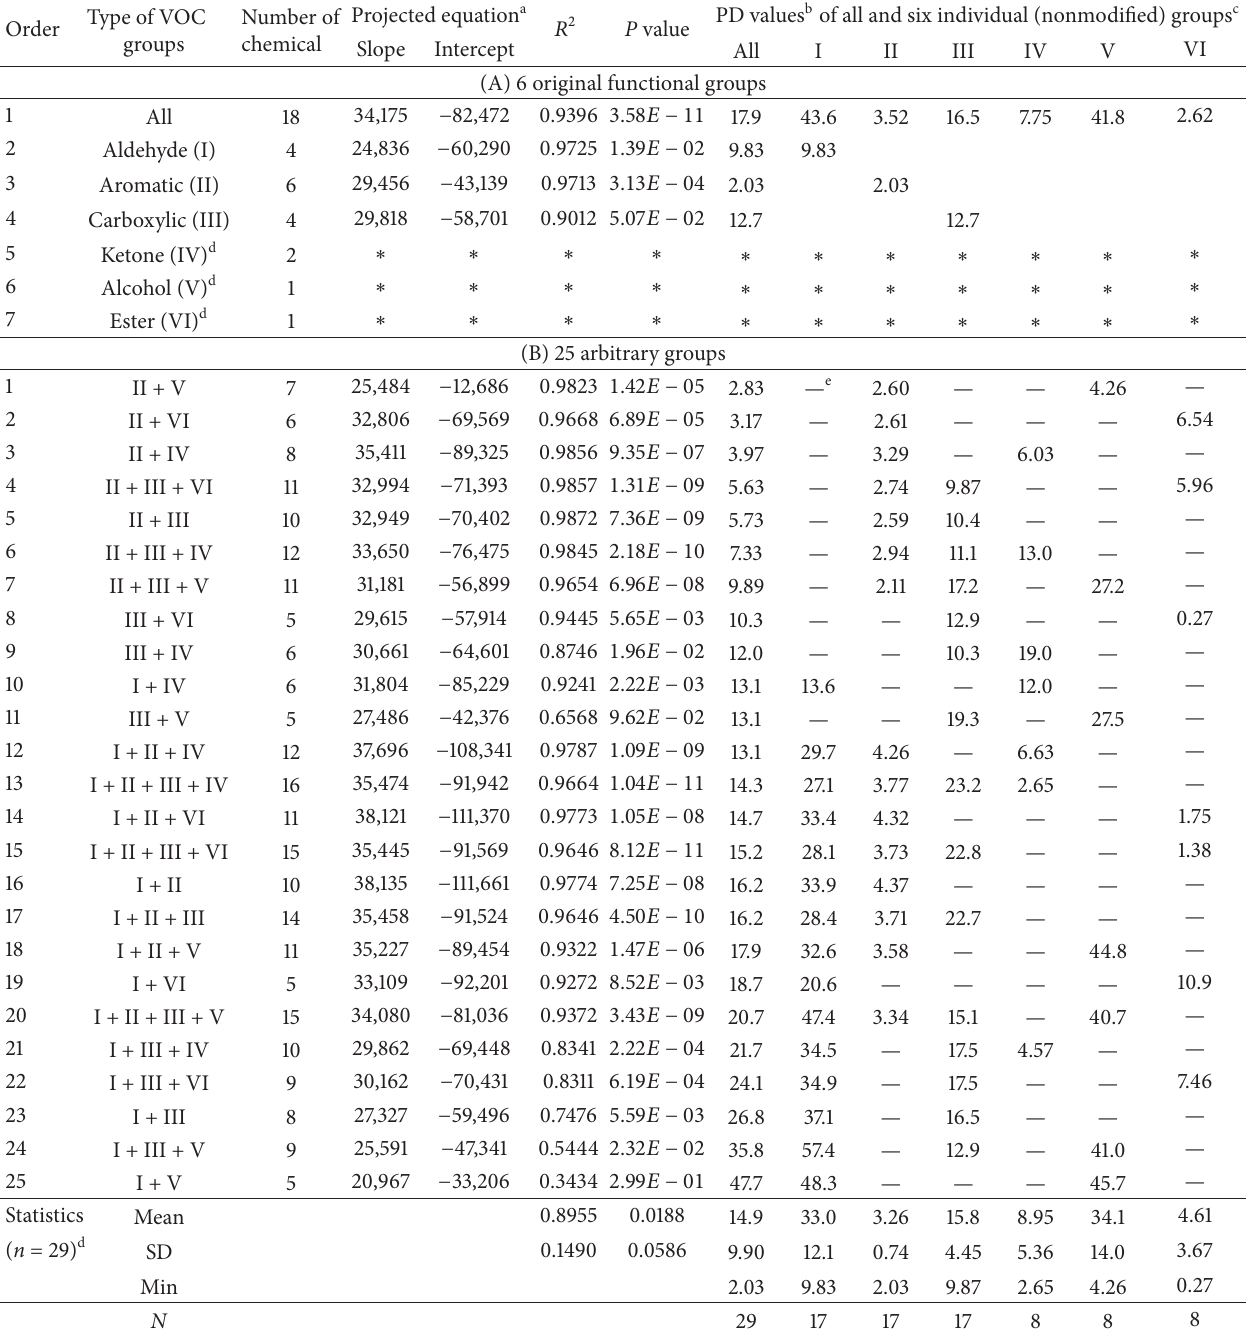
Table 6: Assessment of the PD values between the actual and projected RF values for arbitrarily divided chemical groups. Type of Order